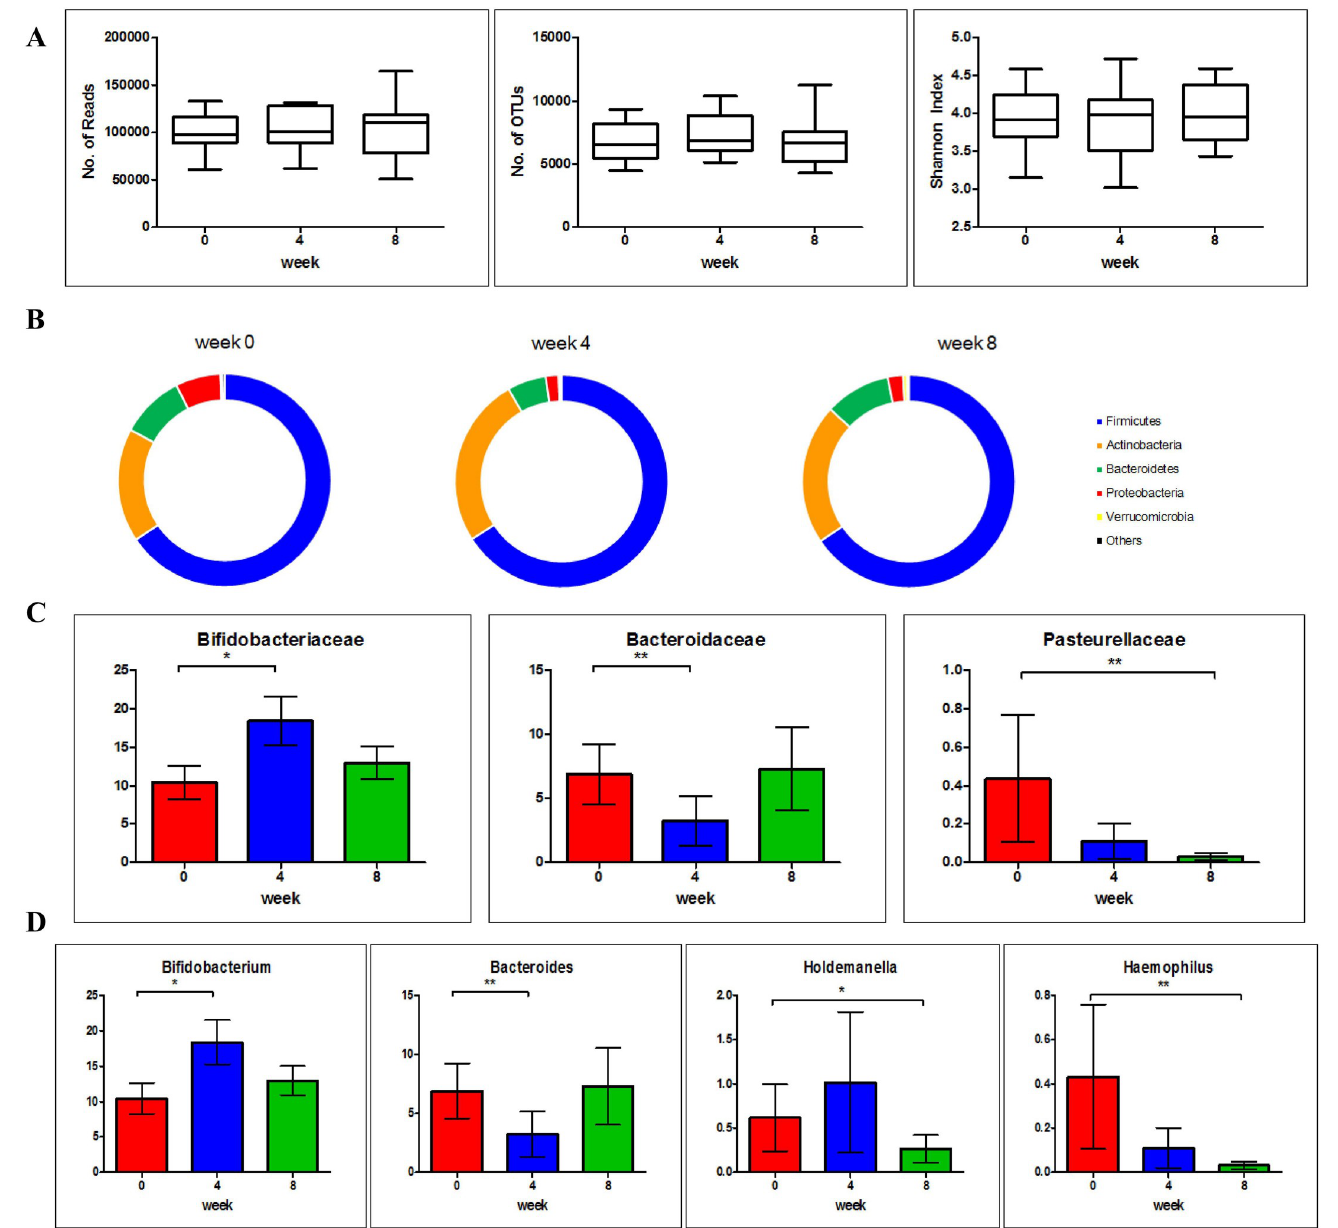
Fig 3. Gut microbial composition in PPS groups before and after HY7714 consumption at 4 and 8 wk. Sequence summary in fecal samples; the number of reads, operational taxonomic units (OTUs), and Shannon index of alpha diversity (A). Relative abundances of gut microbial composition at the phylum (B), family (C) and genus levels (D). Data are analyzed using the Wilcoxon signed-rank test. Results are expressed as the Mean ± SEM. Asterisks ( � and �� ) indicate a significant difference (p < 0.05 and p < 0.01, respectively) in comparison to the control. PPS: per protocol